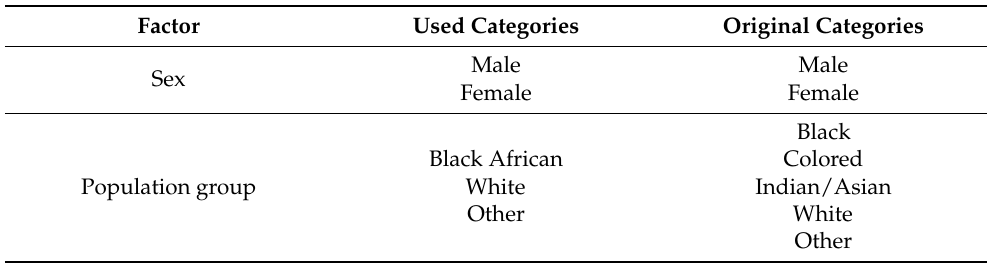
Table 1. Socioeconomic and related variables used as inputs to determine access to healthcare